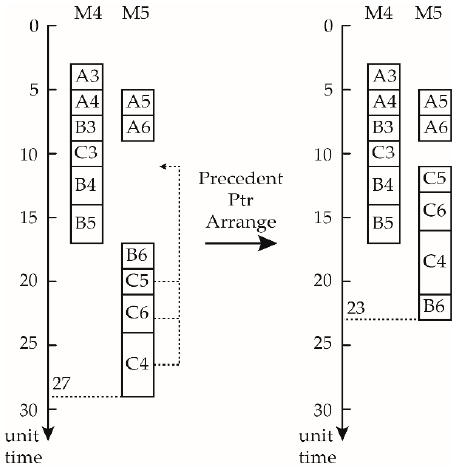
Figure 4. Predecessor pointer adjustment (PPA).